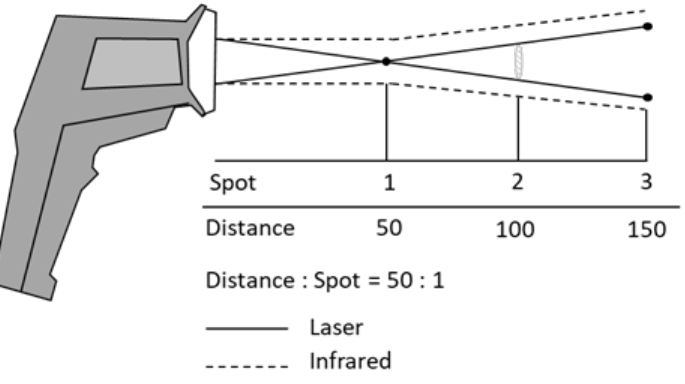
Figure 10. Effect of the target distance (D:S).